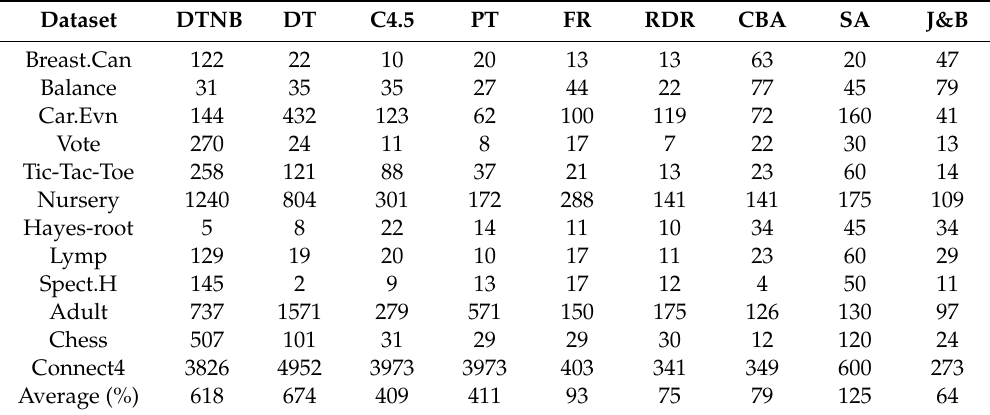
Table 8. The number of classification rules generated by the classifiers.